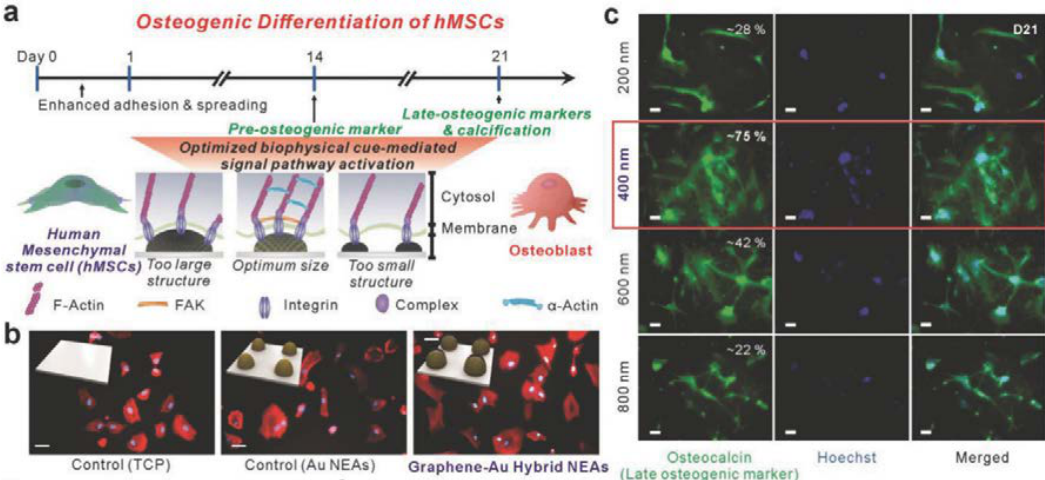
Figure 6. ( a ) Schematic illustration of osteogenic differentiation of human mesenchymal stem cells (hMSCs) on the graphene-Au hybrid NEAs. ( b ) Fluorescence images of hMSCs on TCP, Au NEAs, and graphene–Au hybrid NEAs substrate. ( c ) Fluorescence images of hMSCs differentiated into osteoblasts. Scale bar: 50 μm. The reprint of this figure from [98] is permitted by John Wiley and Sons.